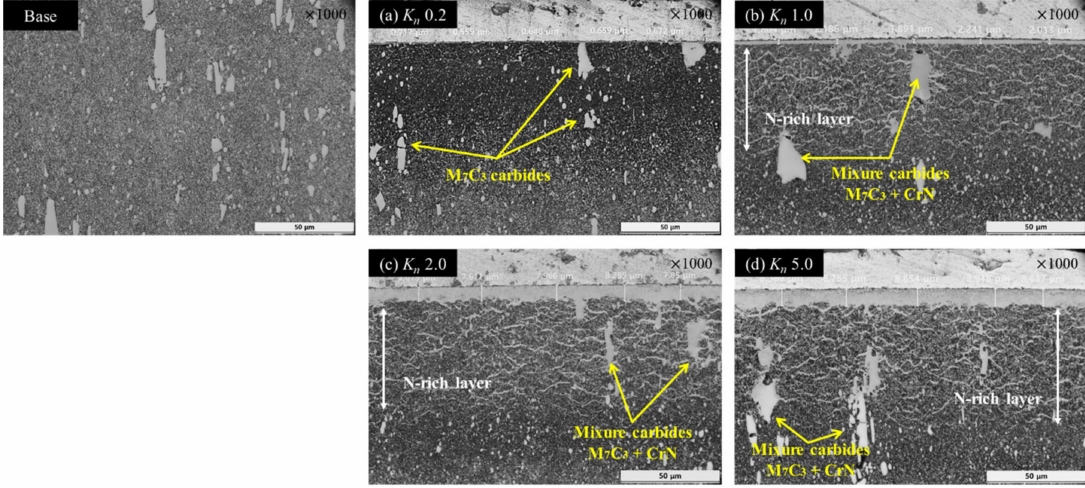
Figure 3. Cross-sectional microstructures of the nitrided specimens after nitriding at 520 ◦ C for 10 h at K n = ( a ) 0.2, ( b ) 1.0, ( c ) 2.0, and ( d ) 5.0 atm − 1/2